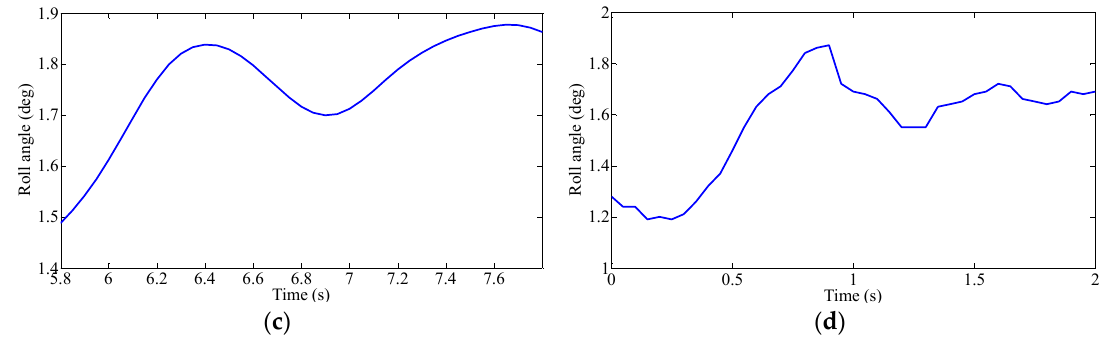
Figure 7. Roll angle under different steering conditions: ( a ) turning right; ( b ) U-turn; ( c ) lane keeping; ( d ) lane changing.